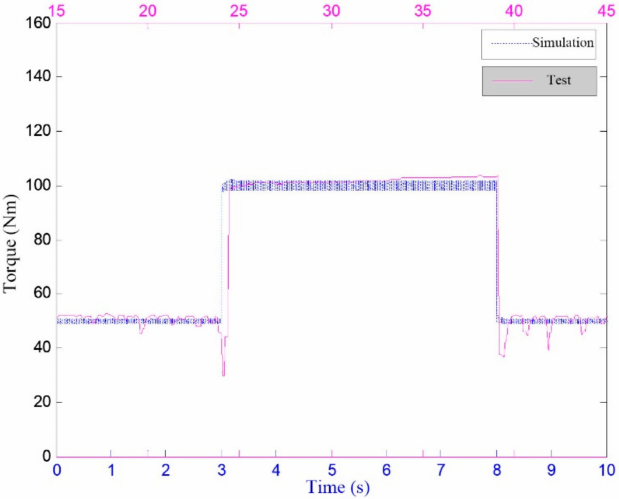
Figure 23. Comparison of torque between simulation and